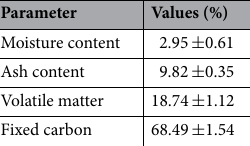
Table 2. Proximate values for Rumex abyssinicus activated